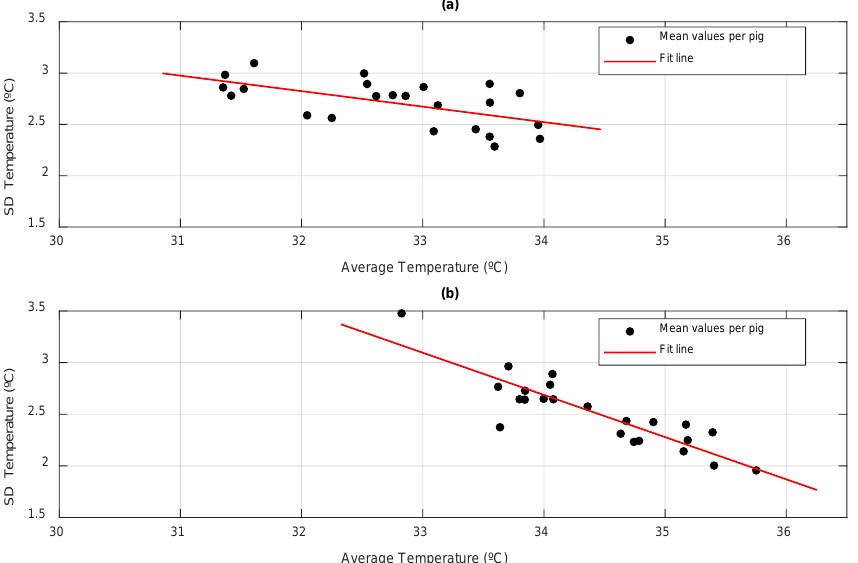
Figure 8. Ratio of the mean and standard deviation of the temperatures recorded separating ( a ) day (r 2 = 0.35; y = − 0.15x + 7.7) and ( b ) night (r 2 = 0.77; y = − 0.41x + 16.6).